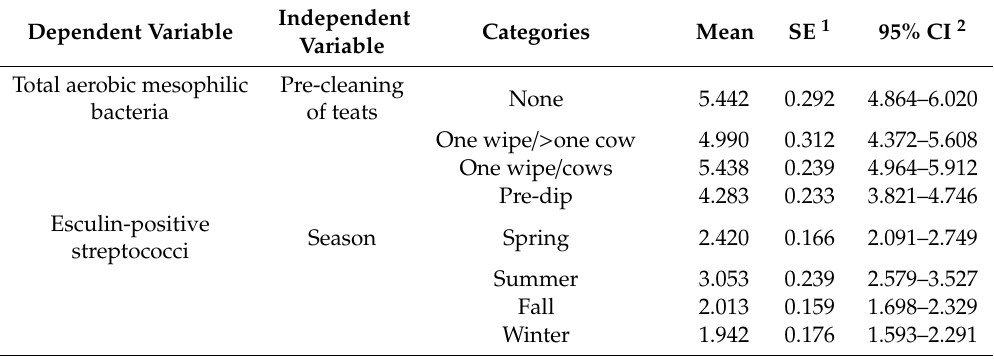
Table 11. Least square means describing di ff erences between categorical risk factors ( = independent variable) associated with environmental pathogen teat-skin load at herd level ( = dependent